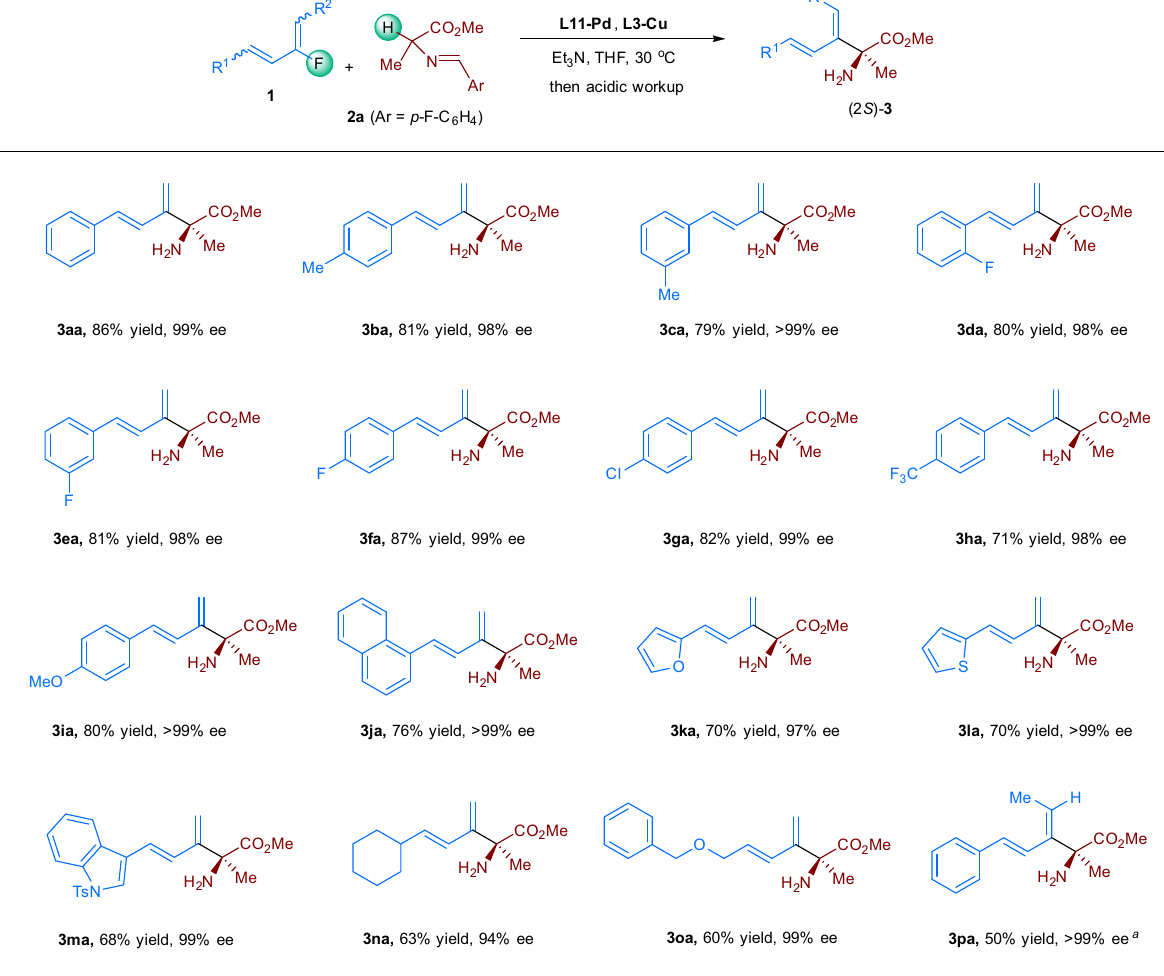
Fig. 2 Substrate scope with respect to the dienyl fl uorides. Reaction conditions: (i) 1a (0.4 mmol), 2a (0.2 mmol), L11-Pd (4 mol%) , L3-Cu (5 mol%), Et 3 N (200 mol%), THF (0.5 mL), 30 °C, 24 h; (ii) citric acid (10 wt%, 4 mL). Isolated yields are provided. The ee values were determined by HPLC on a column with a chiral stationary phase. a L11-Pd (8 mol%), L3-Cu (10 mol%), THF (0.2 mL), 40 °C, 120